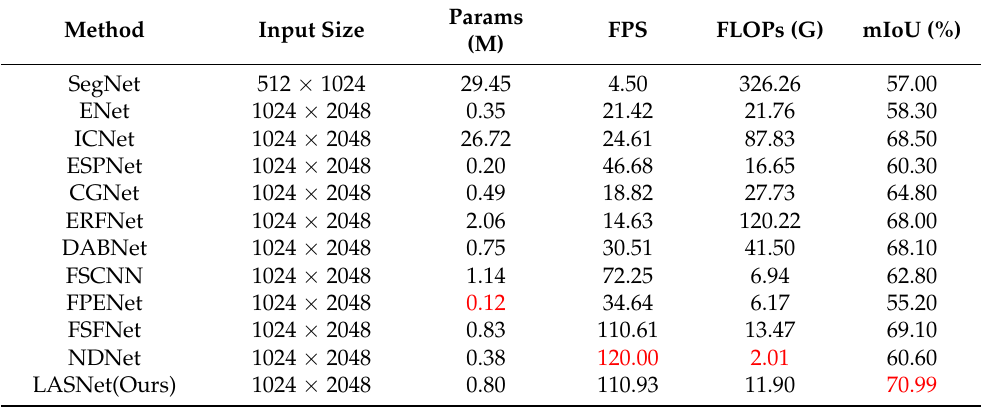
Table 2. Compared with the state-of-the-art approaches on the CityScapes. The red color font indicates the optimal result.